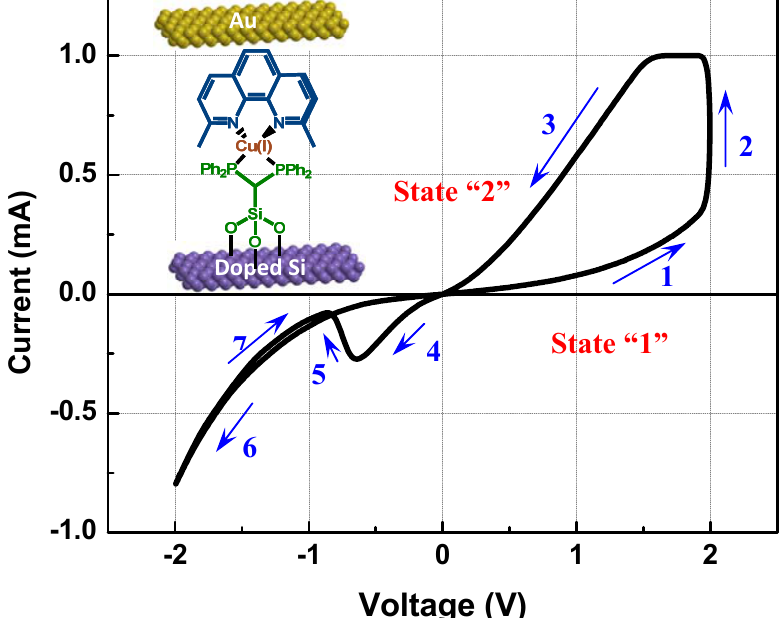
Figure 5. I-V characteristics of monolayer devices with the bisP stator. State “1” represents the low conductivity state, while state “2” is the high conductivity state. The turning voltage between state “1” and state “2” is determined by the redox energy of the copper system. The difference in value of the turning voltage between the positive and negative ranges is due to the different contact energy barriers of the two electrodes. The arrow shows the sequence of voltage scans. Arrows “1” and “3” correspond to the band diagrams in Figure 8, ( a ) and ( b ), respectively, while “4” and “7” correspond to ( c ) and ( d